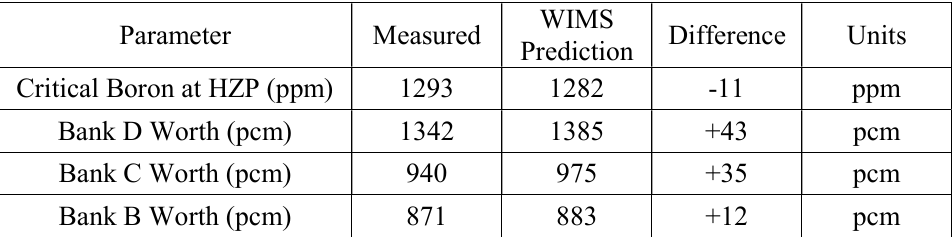
Table I. Zero Power Physics Test Results- Exercise